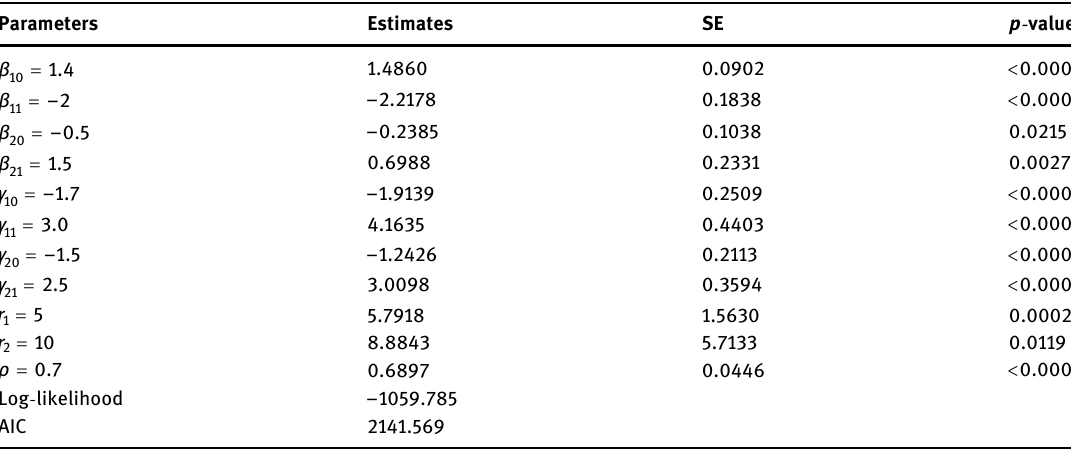
Table 2: Parameter estimates, standard errors, p - values, and the AIC value of the fi tted model M 2 using 500 simulated data points